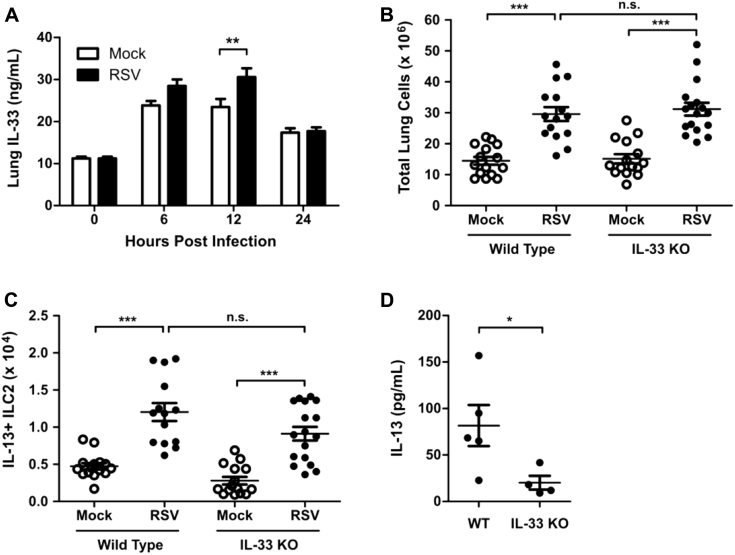
RSV-induced IL-33 and ILC2s. WT or IL-33 KO mice were infected with 3 × 106 PFU of RSV strain 01/2-20, and lungs were harvested for ELISA or flow cytometry. A, ELISA for IL-33 in the whole-lung homogenate. B, Total number of live cells in the lungs at day 4 after infection. C, Total numbers of IL-13+ ILC2s as measured by using flow cytometry at day 4 after infection. D, ELISA for IL-13 in the whole-lung homogenate (right and left lung) at day 4 after infection. Data are plotted as means ± SEMs. For Fig E5, A, n = 5-10 mice per group combined from 2 independent experiments. For Fig E5, B and C, n = 13-17 mice per group combined from 3 independent experiments. For Fig E5, D, n = 4-5 mice per group from 1 independent experiment. *P < .05, **P < .01, and ***P < .001, 1-way (Fig E5, B and C) or 2-way (Fig E5, A) ANOVA. n.s., Not significant.